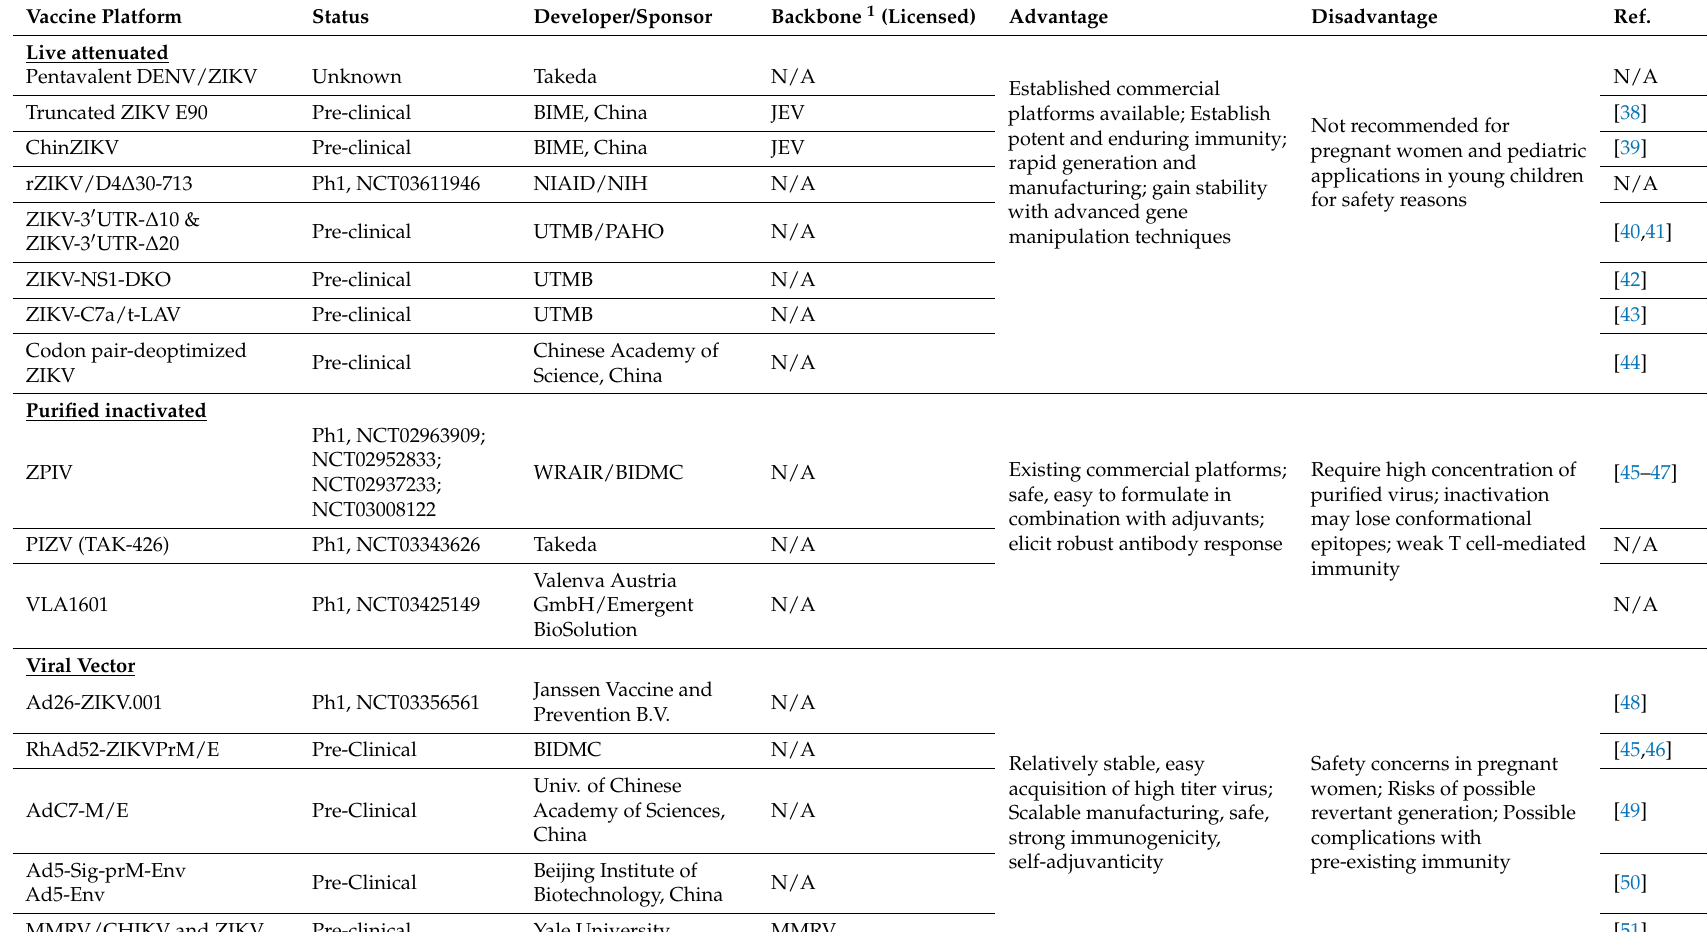
Table 1. Zika virus (ZIKV) vaccine candidates and